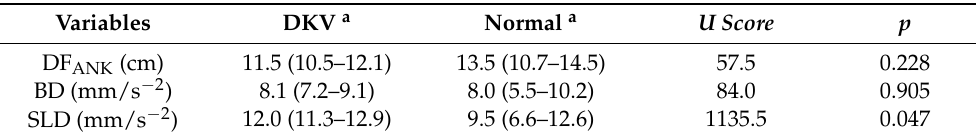
Table 3. Differences in ankle range of motion (DFANK) and core stability assessed in the bird-dog test (BD) and the partial range single-leg deadlift test between those legs categorised as dynamic knee valgus (DKV > 10 ◦ ; n = 35) and normal (DKV ≤ 10 ◦ ; n =